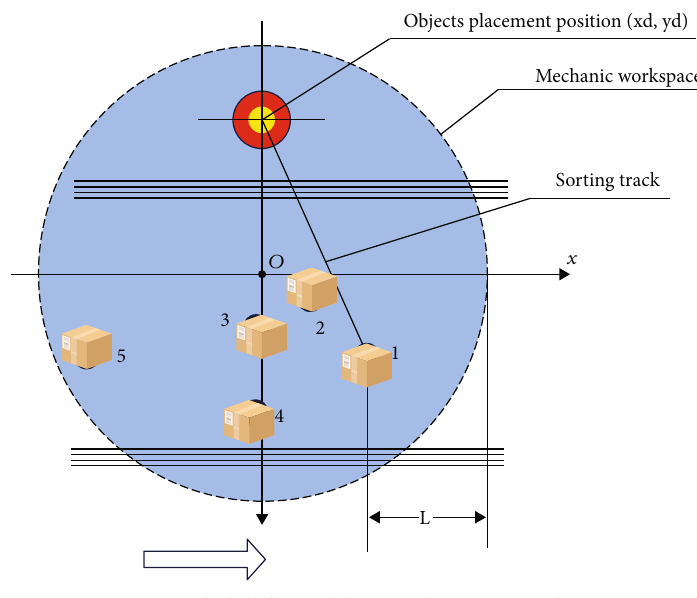
Figure 6: Schematic diagram of conveyor belt speed control parameters.